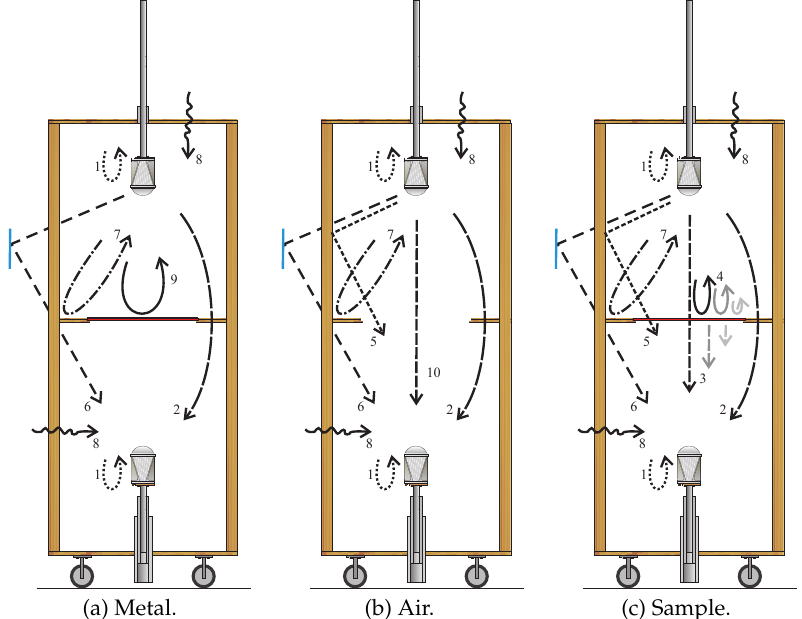
Figure 4. The three configurations used in the free-space calibration: ( a ) metal plate, ( b ) air, and ( c ) material under test. The arrows indicate possible contributions on the